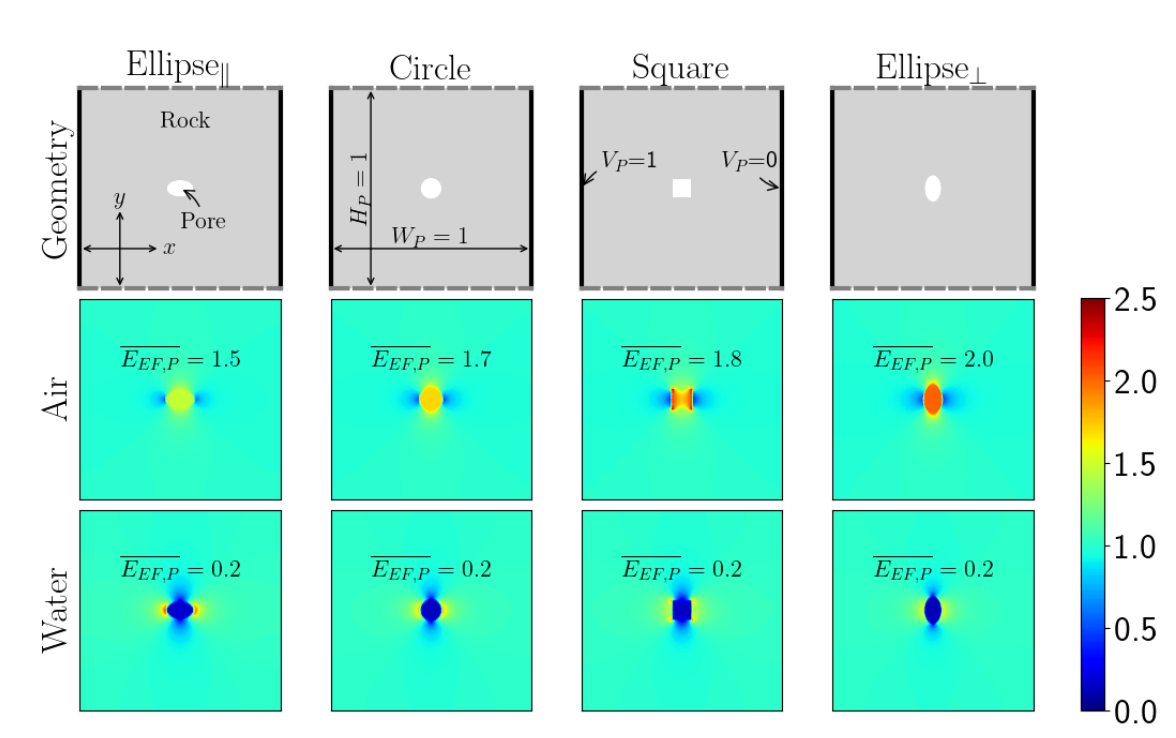
Figure 5. The dimensionless enhancement factor (color bar) of the electric field for the pore-scale simulations, E EF , P , where E EF , P denotes the average enhancement factor across the pore. The enhancement factor is the electric field normalized to the electric field at the domain boundary. The first row shows the model geometry and boundary conditions. The second and third rows show the results for air-filled and water-filled pores,